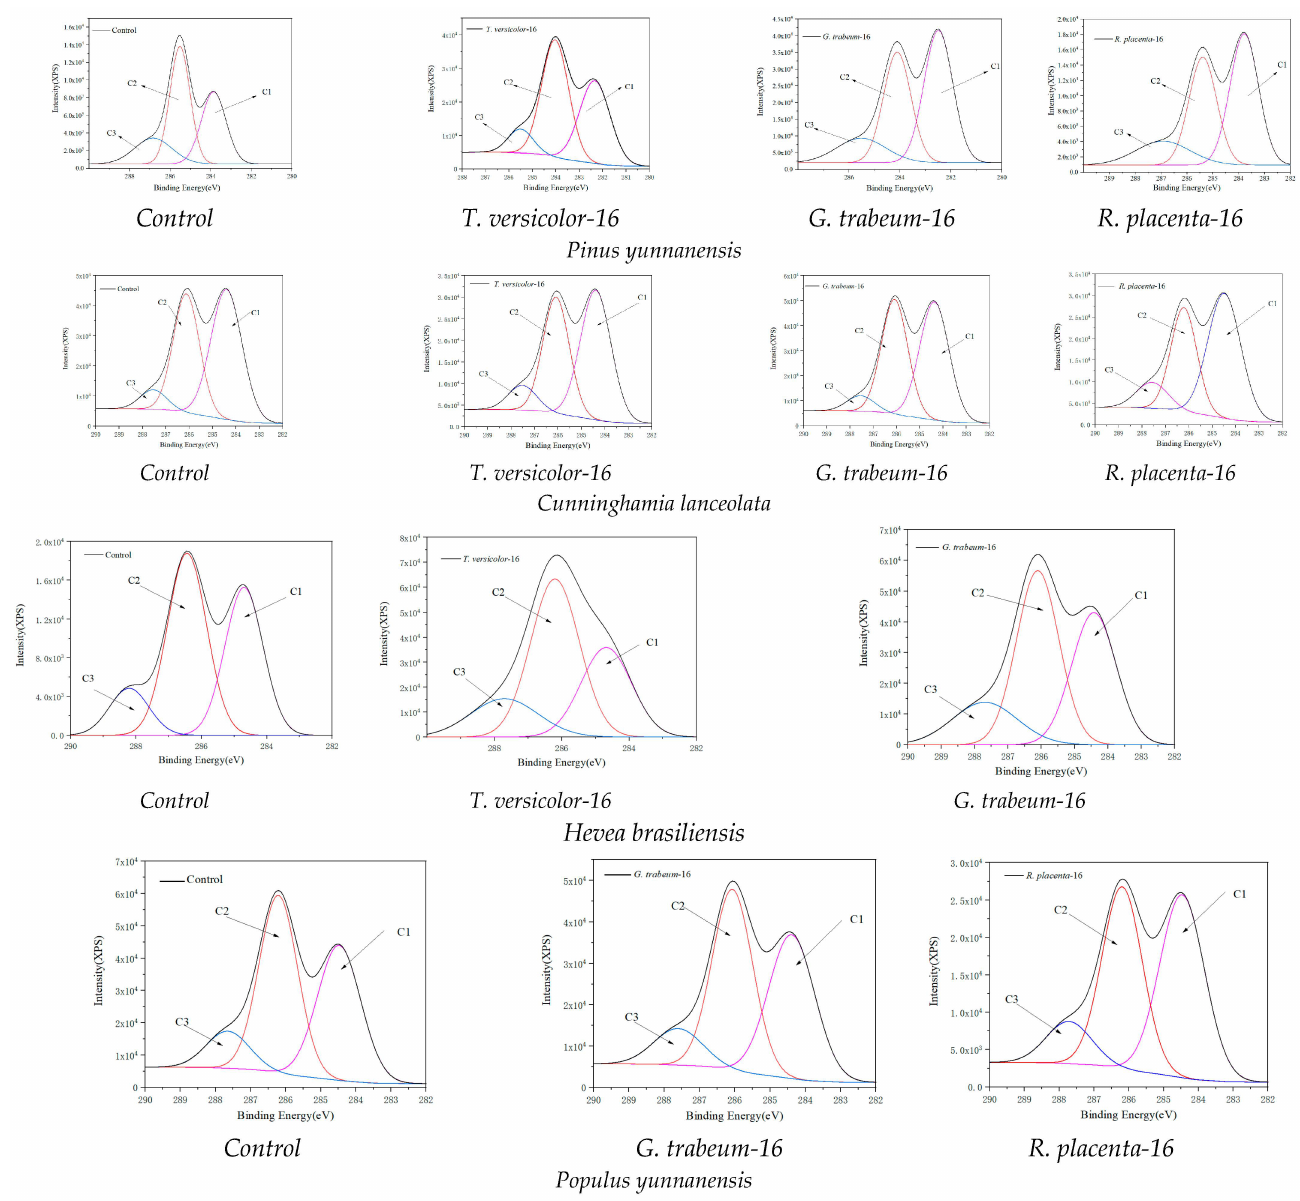
Figure 3. XPS scan of C1s region of wood samples converted by different